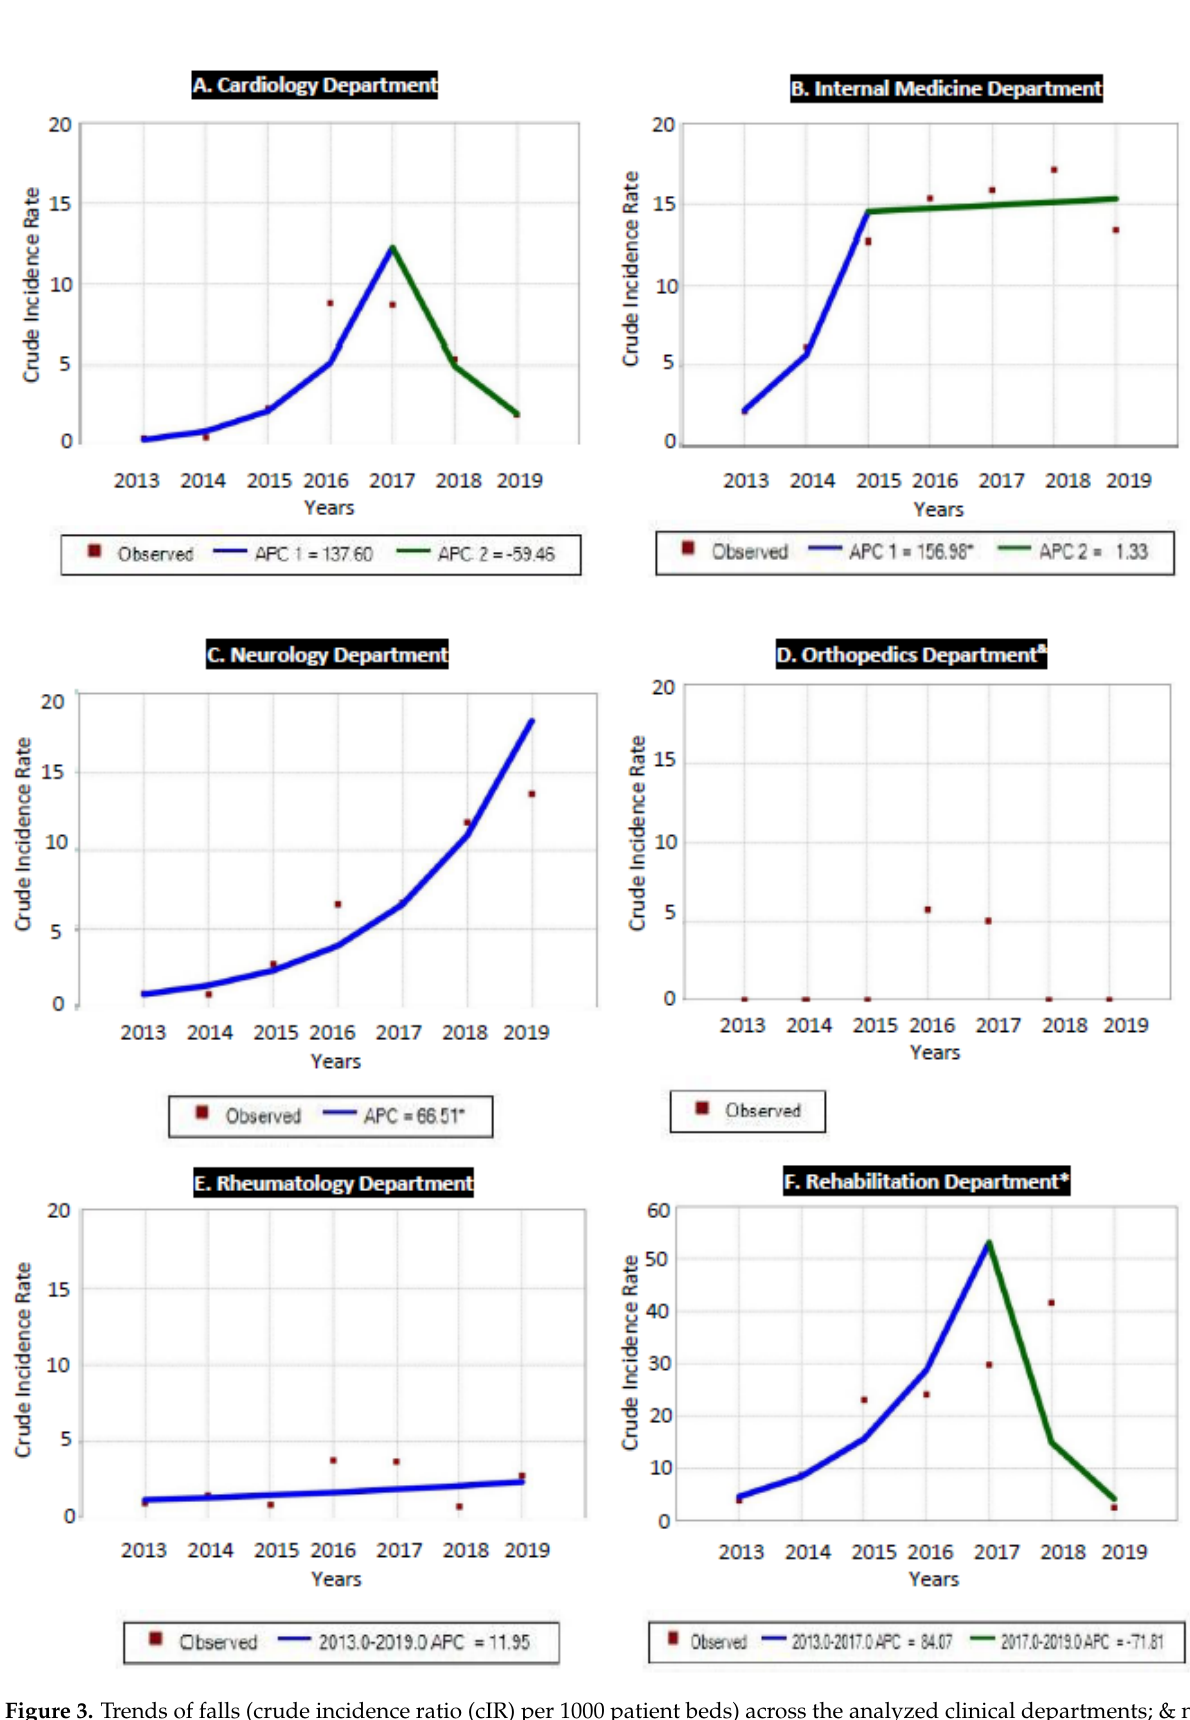
Figure 3. Trends of falls (crude incidence ratio (cIR) per 1000 patient beds) across the analyzed clinical departments; & no trend available due to 0 cases of inpatient falls in several years; * please pay attention to a different scale.